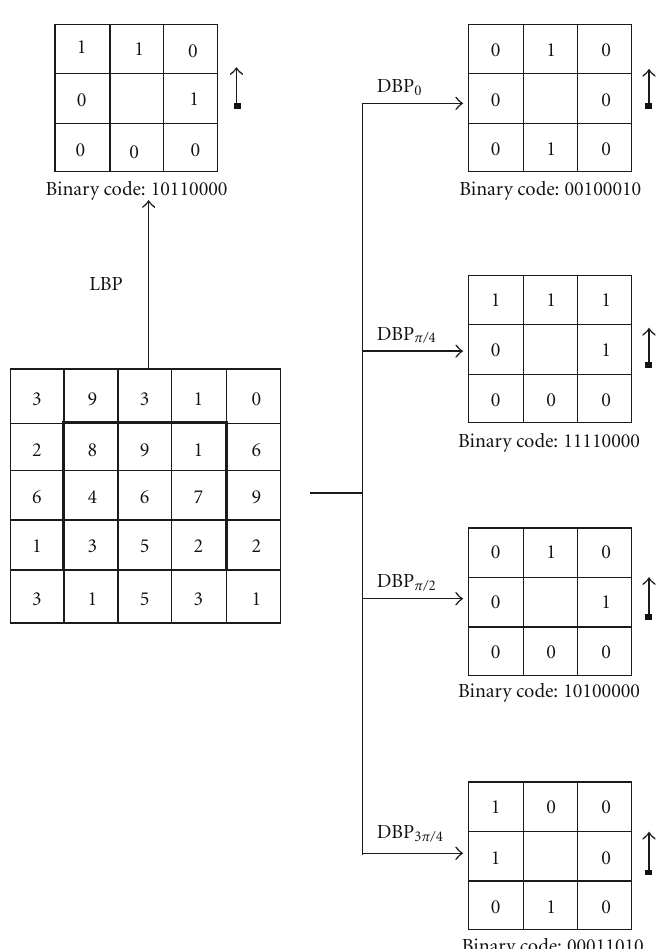
Figure 2: A comparison of LBP and DBP. Bottom-left: the input image with the neighborhood of interest highlighted. Top-left: the binary code by LBP. Right-4-rows: the binary codes by DBP.